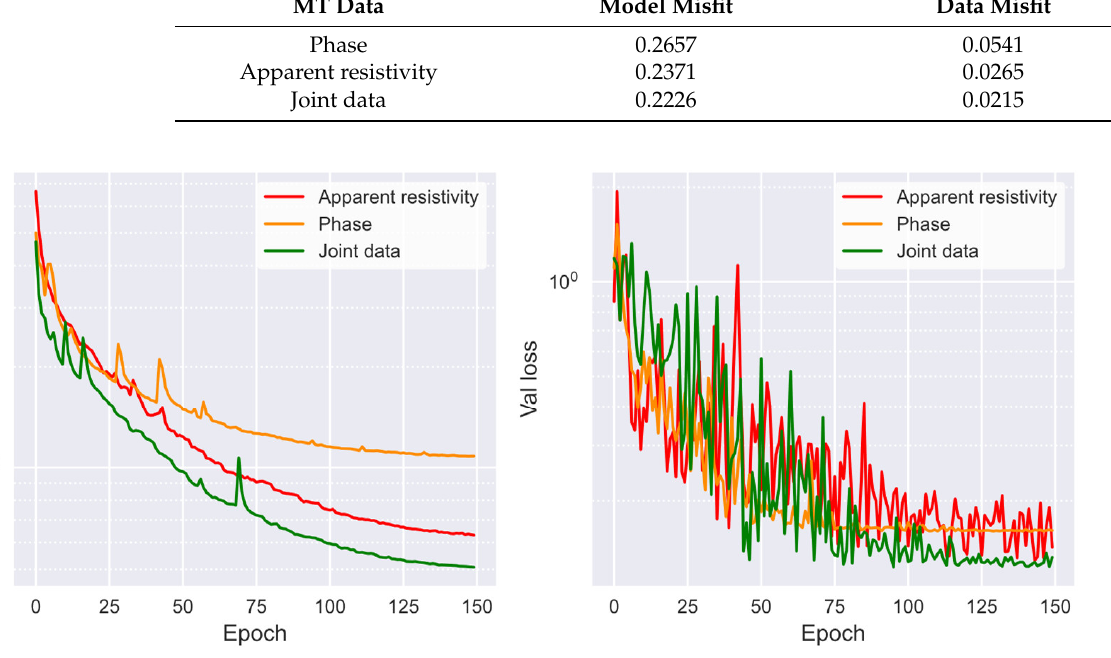
Figure 11. The model and data misfit scatter density plots between the apparent resistivity, phase and joint data for the test set. The left and right columns are the comparison results of model misfit and data misfit separately. The top row places the comparison results between the apparent resis- tivity and joint data. The bottom row shows the comparison results between the phase and joint data. Table 5. Mean model and data misfits of the test set for the apparent resistivity, phase and joint data.